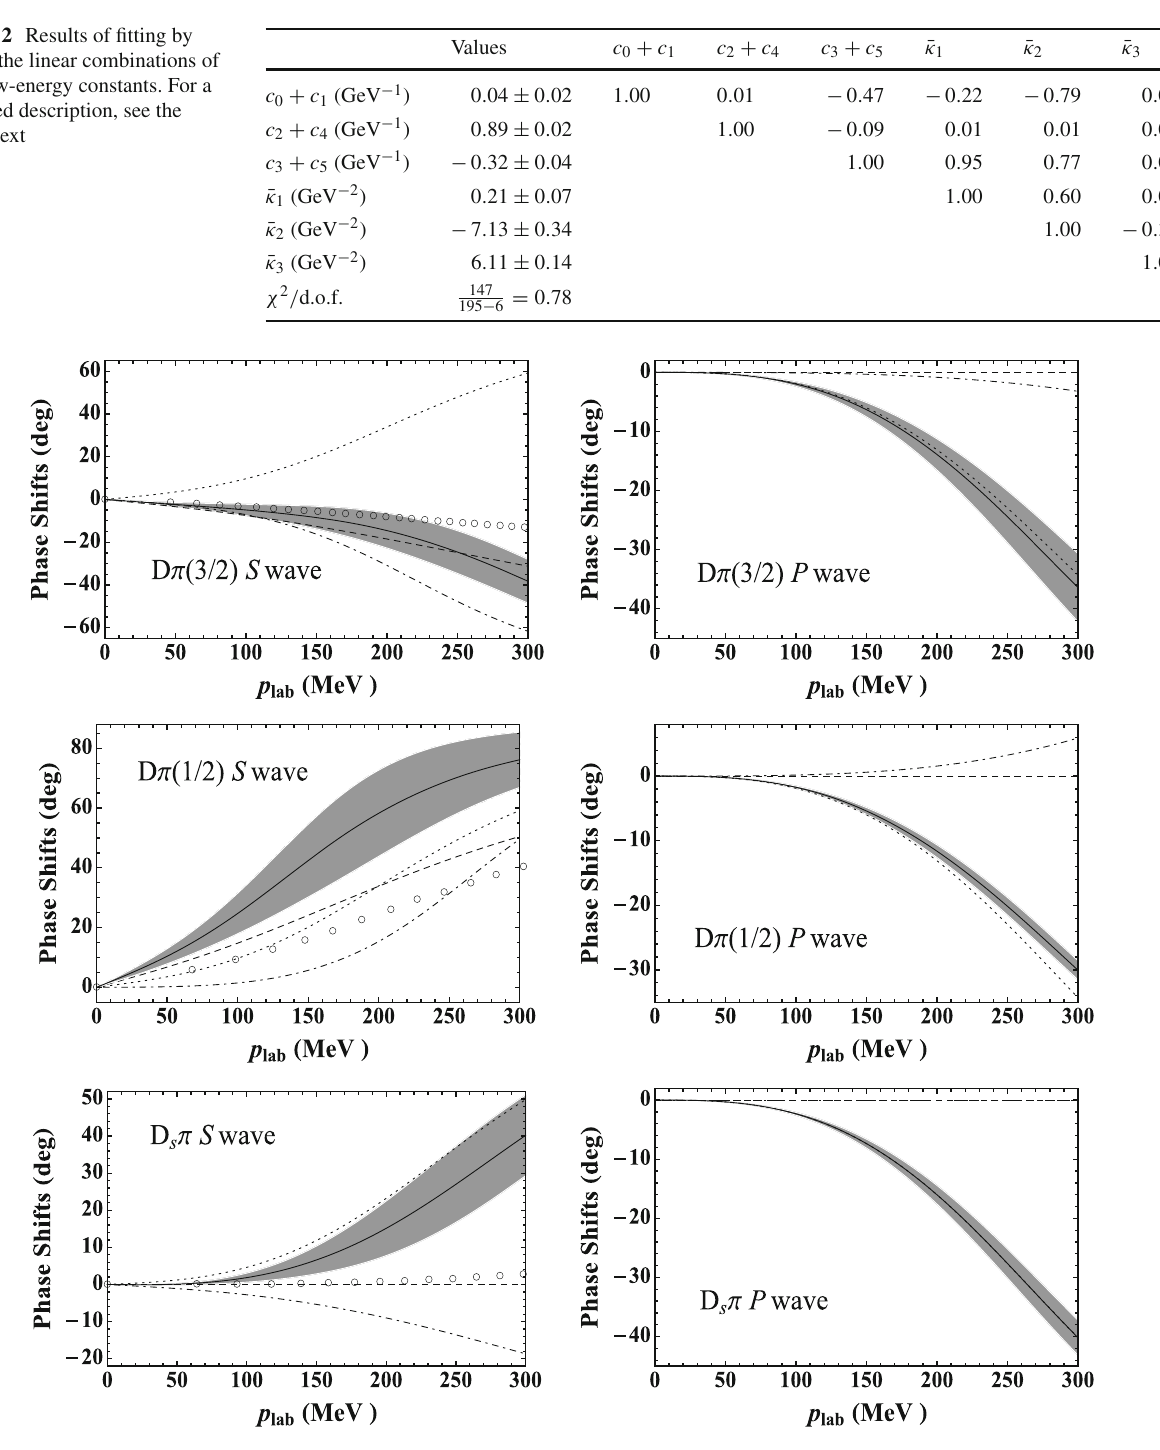
Fig. 3 Predictions for the pion- D meson phase shifts versus the pion laboratory momentum at physical meson values. The dashed, dotted, dash-dotted and solid lines denote the first-, second-, third-order, and their total contributions, respectively. The open circles present the uni-